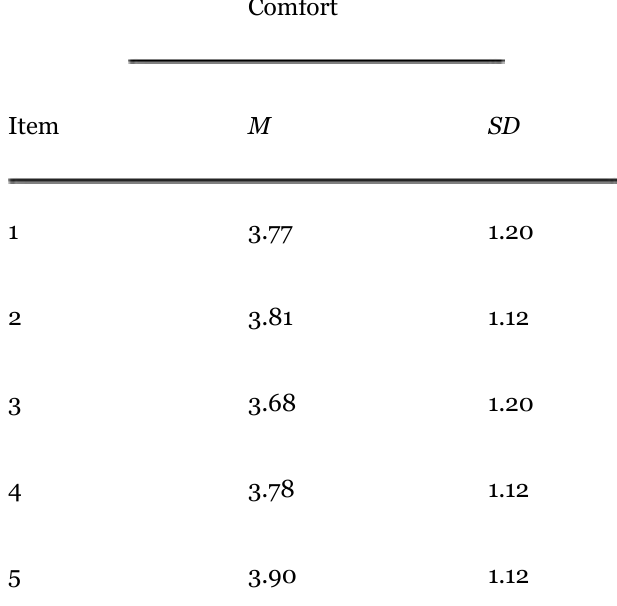
Mean Scores and Standard Deviations